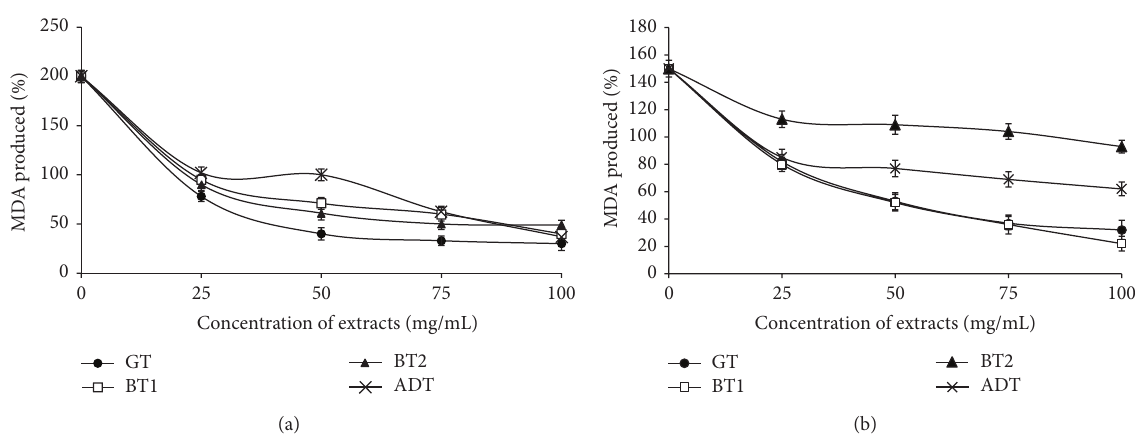
Figure 3: (a) Inhibition of Fe 2+ induced lipid peroxidation in rat pancreas by aqueous extracts from some commercially available teas. GT: Green tea; BT: Black tea; ADT: antidiabetes tea. (b) Inhibition of sodium nitroprusside (SNP) induced lipid peroxidation in rat pancreas by tea infusion from some commercially available teas. GT: Green tea; BT: Black tea; ADT: antidiabetes tea.